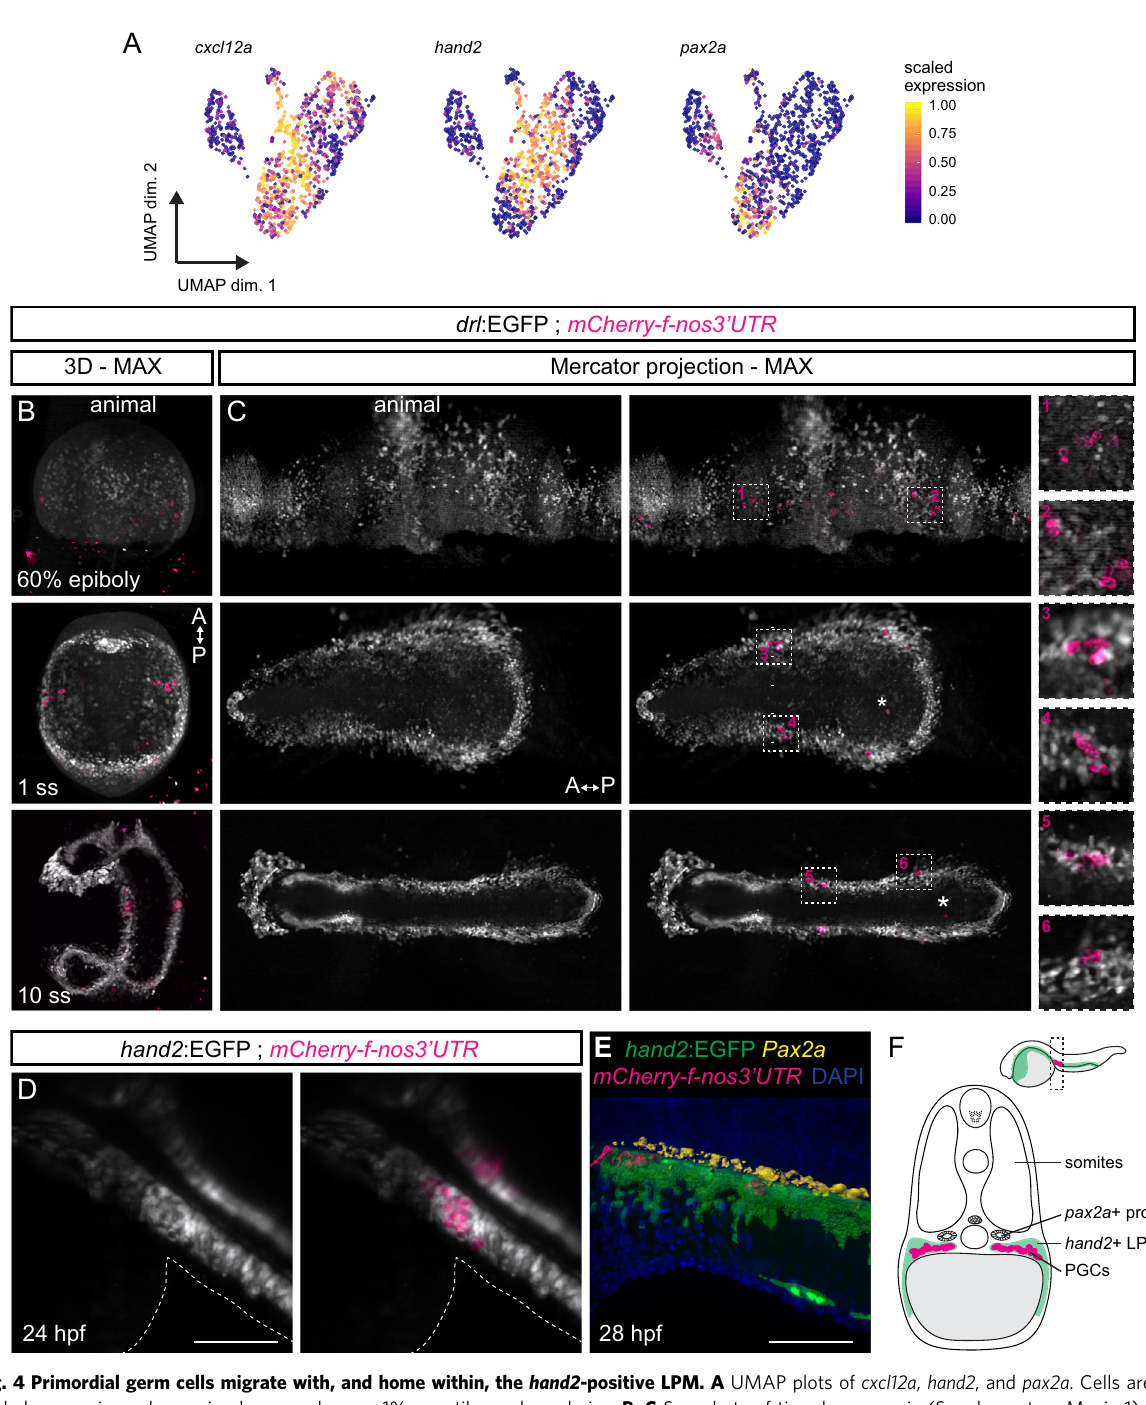
Fig. 4 Primordial germ cells migrate with, and home within, the hand2 -positive LPM. A UMAP plots of cxcl12a , hand2 , and pax2a . Cells are colored by scaled expression values using lower and upper 1%-quantiles as boundaries. B , C Snapshots of time-lapse movie (Supplementary Movie 1) showing drl:EGFP with primordial germ cell (PGC) marker mCherry-f ′ -nos3 ′ UTR , with 3D renderings at 60% epiboly, 1 ss, and 10 ss ( B ) and maximum intensity Mercator projections for the same time points ( C ). The PGCs migrate from four different clusters during gastrulation into two bilateral clusters during somitogenesis (boxed regions). Note the sparse (lost) PGCs located within the endoderm (asterisks). Animal side is for 60% epiboly to the top, anterior for 1 ss and 10 ss ( B ) to the top and ( C ) to the left. D Imaging of hand2:EGFP with mCherry-f ′ -nos3 ′ UTR showing a dorsal view at 24 hpf: the PGC clusters fall completely within the hand2:EGFP domain. The outlines of the yolk extension are highlighted. E Segmented 3D rendering of a hand2:EGFP; mCherry-f ′ -nos3 ′ UTR double-positive embryo stained with anti-Pax2a (yellow) and DAPI (blue) at 28 hpf. F A schematic transverse section of a 24 hpf embryo showing two bilateral PGC clusters (magenta) lateral of the developing gut, ventral-lateral of the Pax2a-positive developing pronephros (yellow) within the cxcl12a -high hand2 -positive LPM/coelomic epithelium (green). Scale bar D , E 250 μ